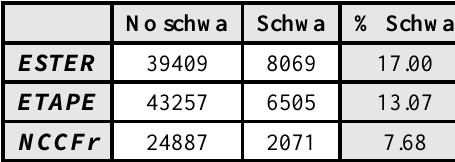
Table 2. Number of word-final schwas by